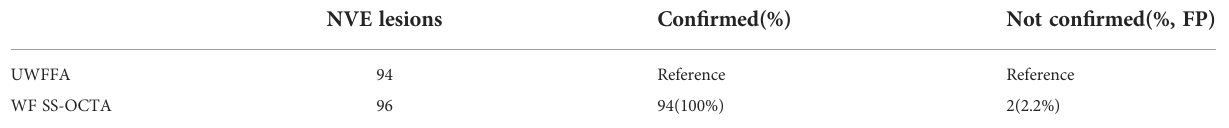
TABLE 3 Detection rates of NVEs in proliferative diabetic